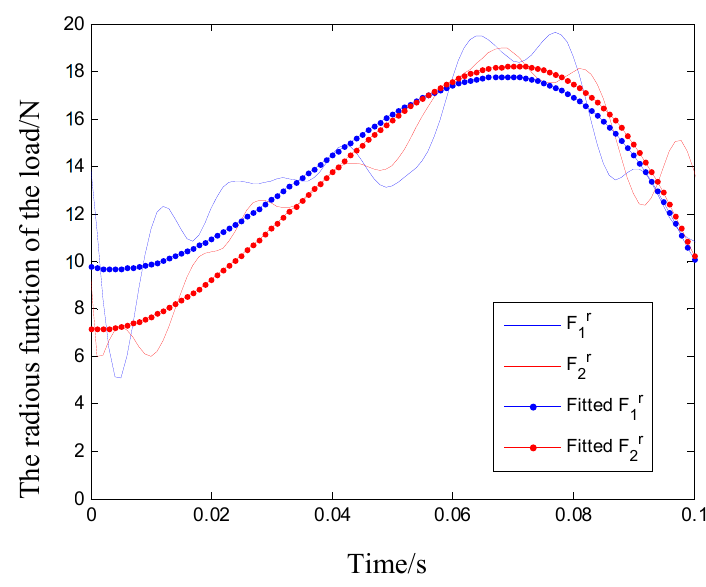
Figure 11. The identified radius functions of the random dynamic loads.